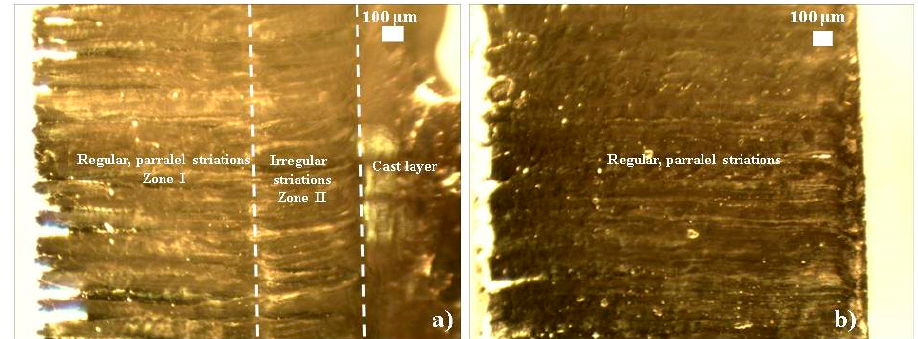
Figure 7. Appearance of the laser cut on Nimonic surface: ( a ) before optimization; ( b ) after optimization, taken by an optical microscope (magnification 30×).